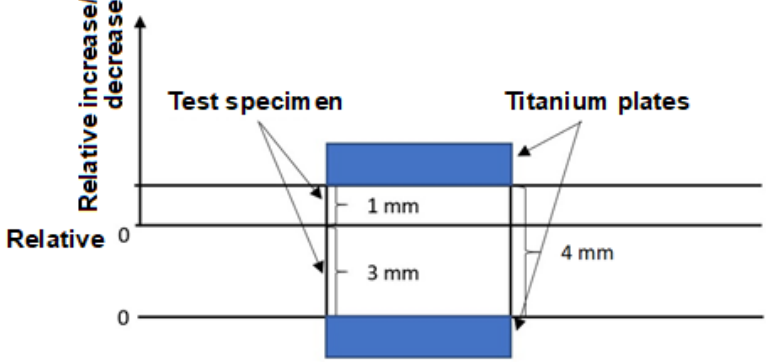
Figure 3. TMA measurement principle.